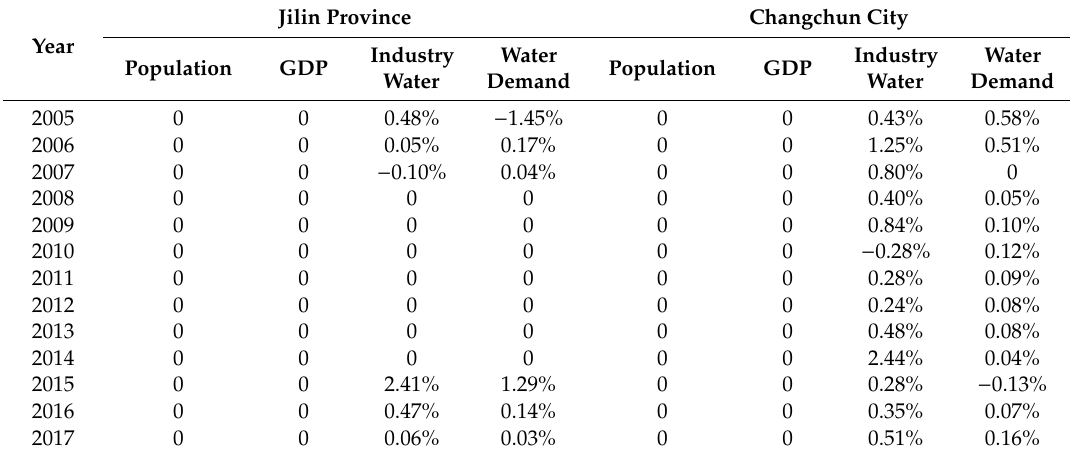
Table 5. Relative errors of the main variables between simulated data and historic data.